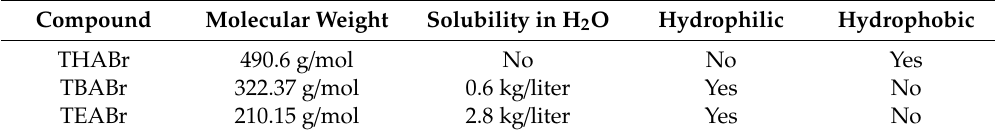
Table 1. Characteristics of the standard ions (dissolved in water methanol) used in the study. Compound Molecular Weight Solubility in H 2 O Hydrophilic 322.37 g / mol Yes No TEABr 210.15 g / mol 2.8 kg / liter Yes